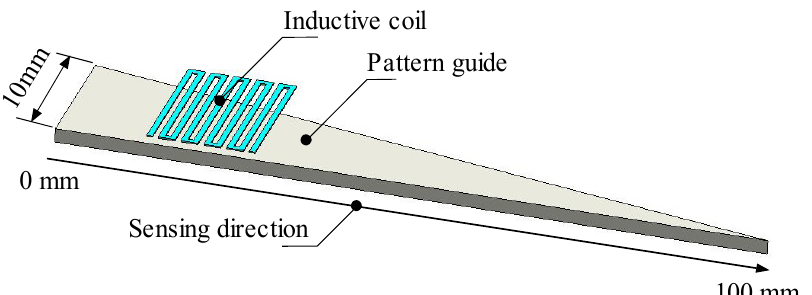
Figure 1. Structure of thin type of linear displacement